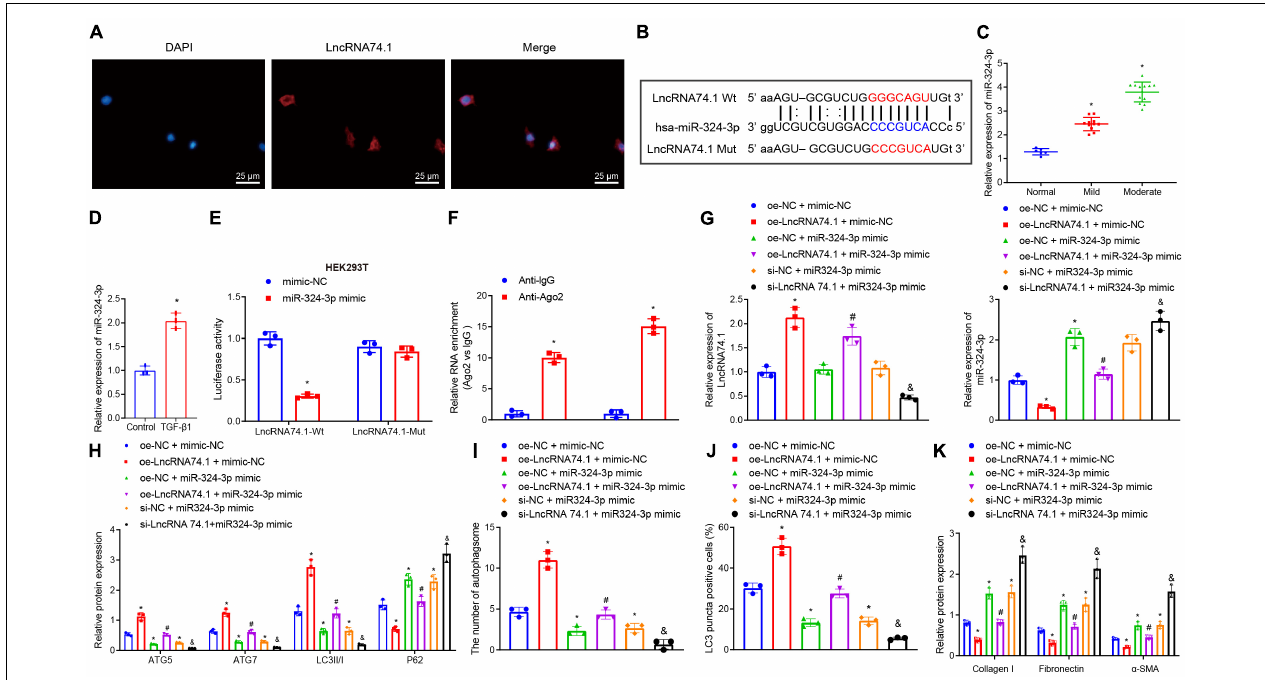
FIGURE 1 | LncRNA 74.1 downregulates miR-324-3p to promote cell autophagy and inhibit renal fibrosis. (A) The subcellular localization of lncRNA 74.1 by FISH assay ( × 400); (B) prediction of binding site between lncRNA 74.1 and miR-324-3p by miRanda software (v3.3a); (C) RT-qPCR results of miR-324-3p expression in 30 renal tissue samples; (D) RT-qPCR results of miR-324-3p expression in HK-2 cells exposed to TGF- β 1; (E) targeting relationship between lncRNA 74.1 and miR-324-3p by dual-luciferase reporter gene assay; (F) binding of lncRNA 74.1 and miR-324-3p with Ago2 by RIP assay; (G) RT-qPCR results of lncRNA 74.1 and miR-324-3p expression in HK-2 cells with different treatments; (H) level of autophagy-related proteins by Western blot; (I) TEM observation of autophagosomes in HK-2 cells with different treatments; (J) proportion of LC3 positive cells in the HK-2 cells with different treatments by immunofluorescence assay; (K) protein level of fibrosis markers in HK-2 cells with different treatments by Western blot. * p < 0.05 as compared with normal, control, mimic-NC, anti-lgG, or oe-NC + mimic-NC; # p < 0.05 as compared with oe-LncRNA74.1 + mimic-NC; & p < 0.05 as compared with si-NC + miR-324-3p mimic. The measurement data were expressed as mean ± standard deviation. Data between the two groups were compared using the unpaired t- test. One-way ANOVA was used for data comparisons among multiple groups, followed by Tukey’s post hoc test. The cell experiments were repeated three times independently.